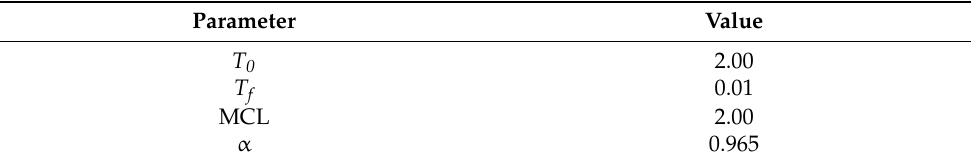
Table 3. Simulated annealing (SA) parameter values for the convection-diffusion problem.